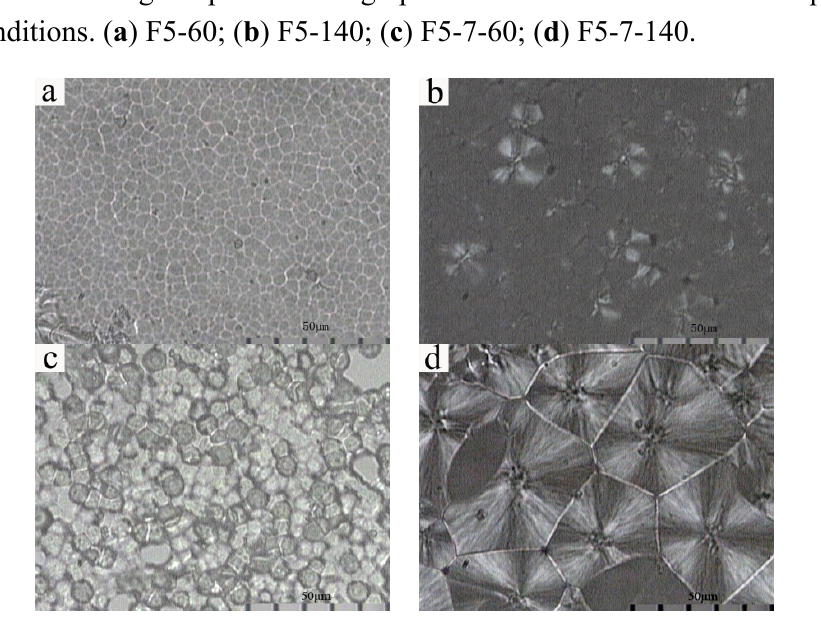
Figure 8. Polarized light optical micrograph of solution-cast membranes prepared